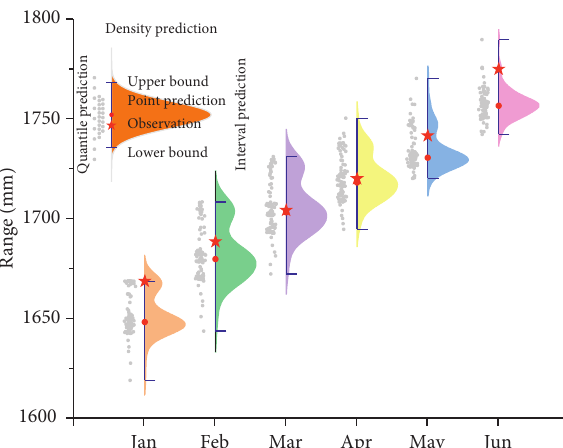
Figure 8: Probability density distribution of predictive displace- ment based on polynomial KSVMQR at ZG287 spanning the period of January 2015 to June 2015.